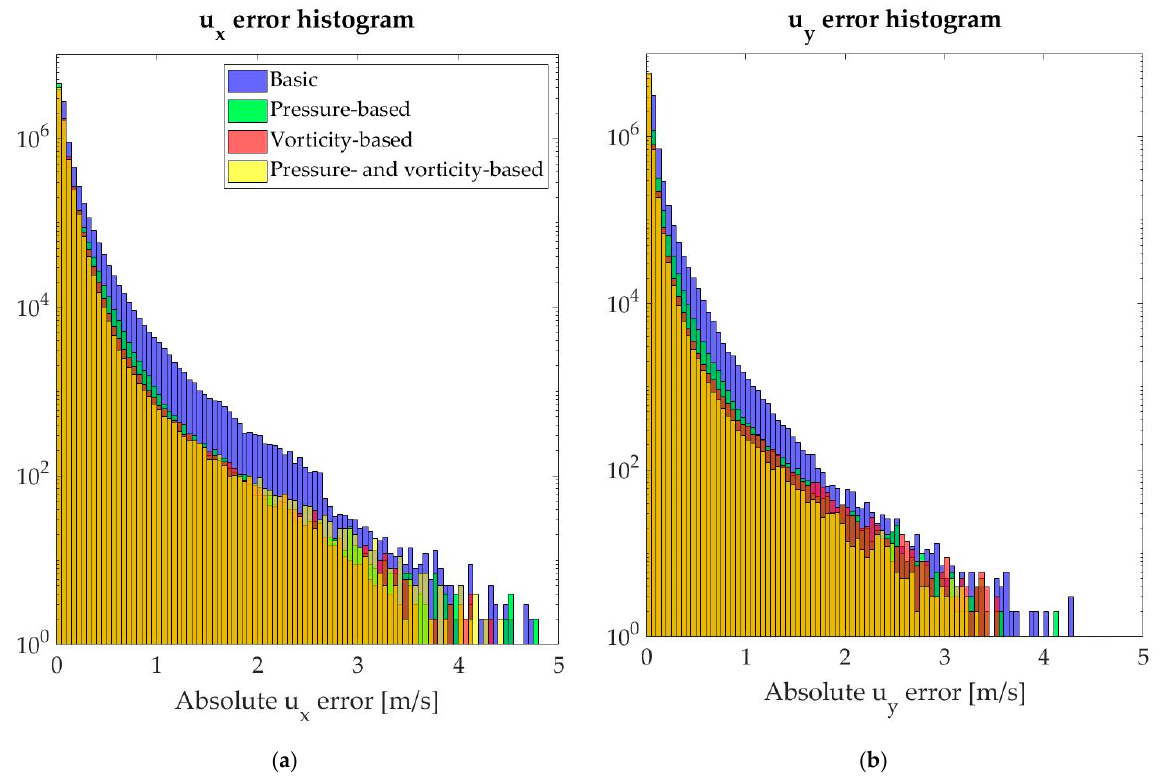
Figure 9. Absolute error distribution. ( a ) Absolute u x error; ( b ) Absolute u y error. Table 4. Computational time required by each studied method to predict the velocity